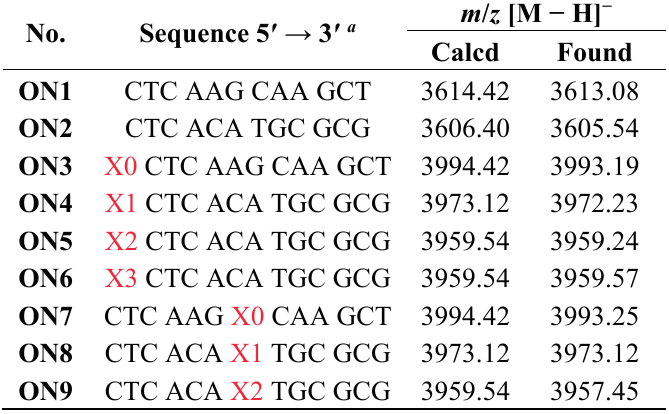
Table 1. Sequences of oligodeoxyribonucleotides and MALDI-TOF MS data.